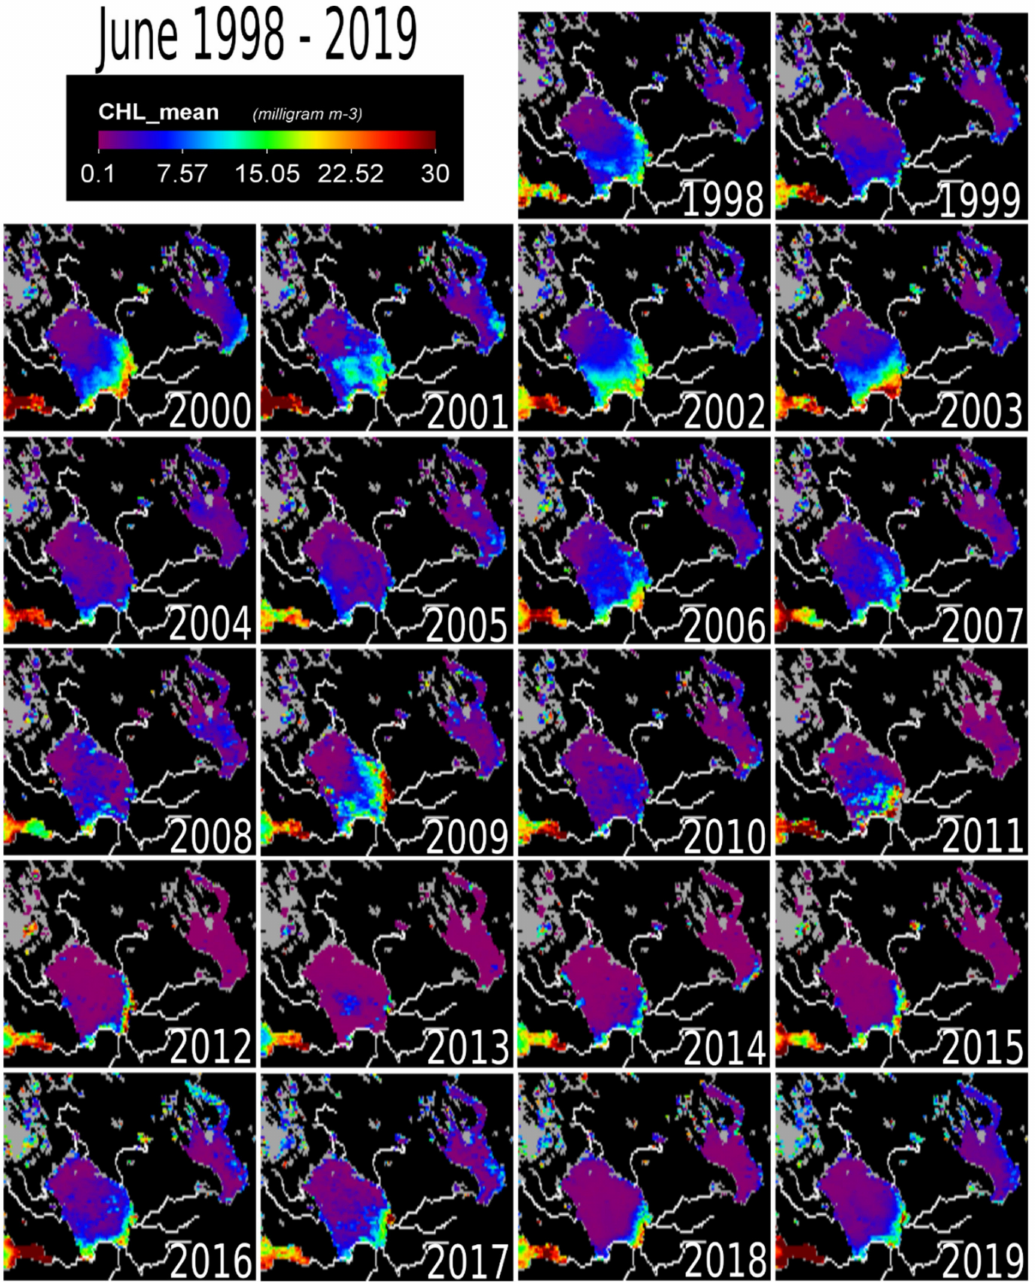
Figure 3. The map of chlorophyll-a concentration at Lake Ladoga for the month of June (1998–2019). Partially displayed as reference points are the Gulf of Finland (Southwest) and Lake Onega